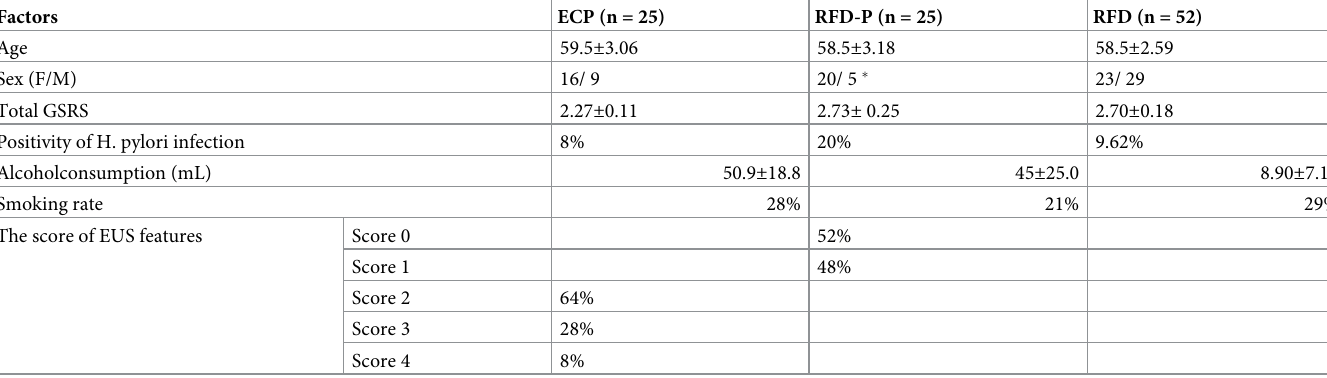
Table 1. Characteristics of ECP patients, RFD-P patients and RFD